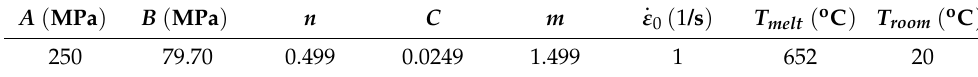
Table 2. The constants of Johnson–Cook material model of AA6061-T6